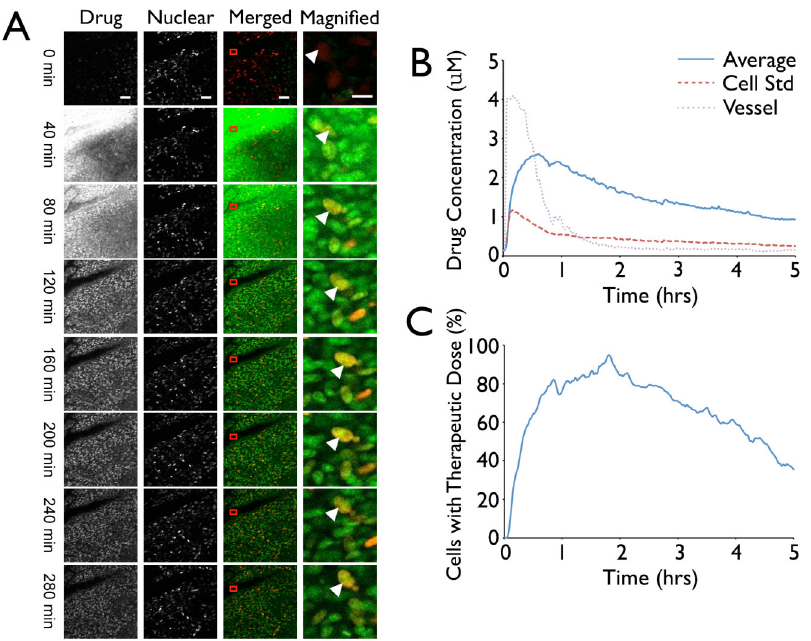
Figure 5. Analysis of average nuclear drug concentrations over time. A. Representative images from a 5 hour PARP inhibitor pharmacokinetics assay. Far-Left Panel: drug distribution. Scale bar represents 50 m m. Middle-Left Panel: H2B Nuclear Marked tumor cells. Scale bar represents 50 m m. Middle-Right Panel: merged images displaying both the drug (green) and tumor cells (red). An area of the closest vessel was also selected to analyze the dynamics of drug distribution through the vasculature (Red box). Scale bar represents 50 m m. Far-Right Panel: Magnified cells from the presented image shown over time. The white arrow indicates a single cell visually tracked throughout the course of the video. Scale bar represents 10 m m. B. The average and standard deviation of nuclear drug concentration in all cells over time was analyzed using the described segmentation algorithm. The vessel concentration dynamics were also analyzed by quantifying drug channel fluorescence within an area of the vessel. C. The number of cells receiving a therapeutic dose of the drug over time.